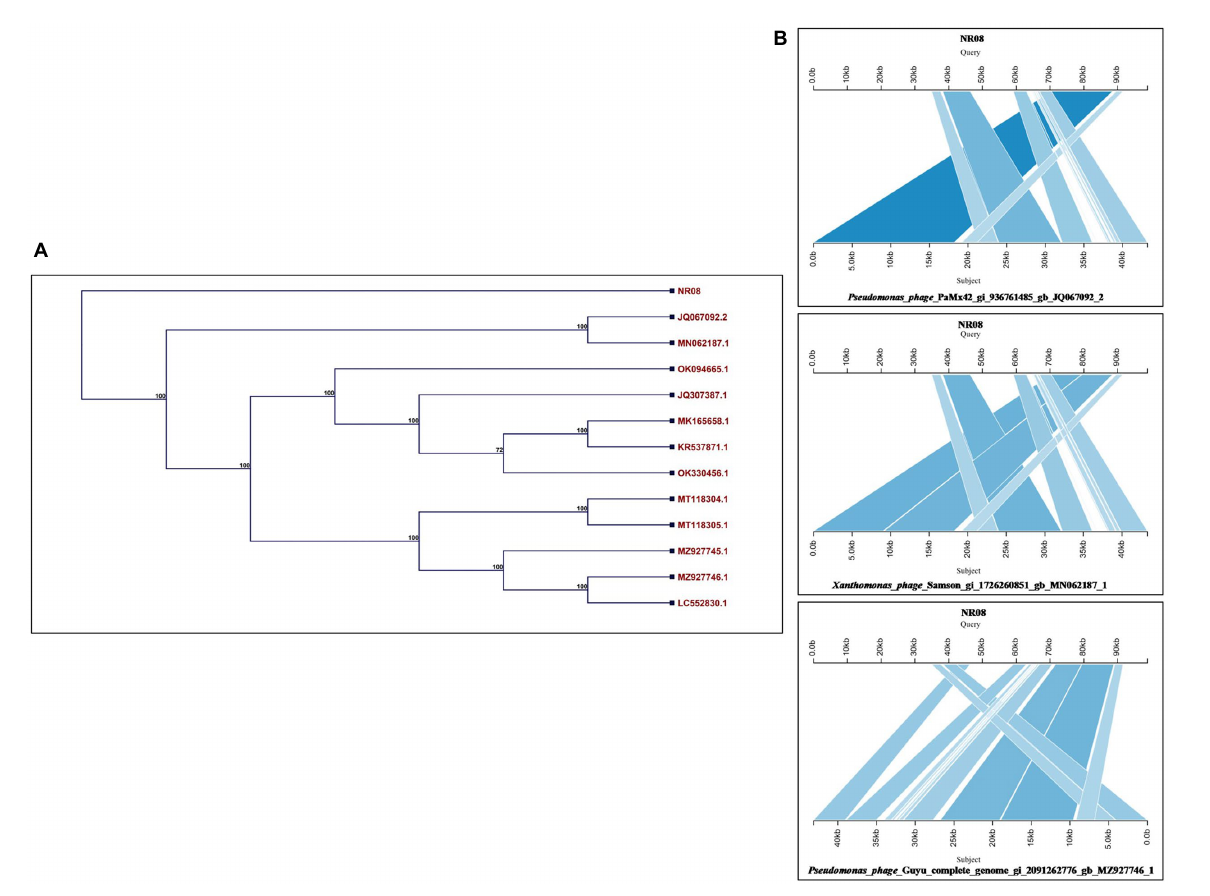
FIGURE 7 (A) Phylogenetic tree based on the whole-genome sequence of vB_XooS_NR08 and its most closely related phages data available with NCBI based on nucleotide identity. A phylogenetic tree was generated using the neighbor-joining method with 500 bootstrap replicates The details of WGS of Xoophages shown in the phylogenetic tree are NR08— Xanthomonas oryzae phage vB_XooS_NR08; JQ067092.2— Pseudomonas phage PaMx42; MN062187.1— Xanthomonas phage Samson; OK094665.1— Pseudomonas phage vB_Pae_W3 isolate sewage; JQ307387.1— Pseudomonas phage vB_ Pae-Kakheti25; MK165658.1— Pseudomonas phage vB_PaeS_SCUT-S4; KR537871.1— Stenotrophomonas phage vB_SmaS-DLP_2; OK330456.1— Pseudomonas phage TehO; MT118304.1— Pseudomonas phage Epa40; MT118305.1— Pseudomonas phage Epa4; MZ927745.1— Pseudomonas phage Kaya; MZ927746.1— Pseudomonas phage Guyu; LC552830.1— Pseudomonas phage vB_PaeS-Yazdi-M DNA. (B) Pairwise BLASTn comparison of the complete genome DNA sequence of NR08 phage with most closely related phages. The gray areas between the genome maps indicate the level of identity at different regions of the